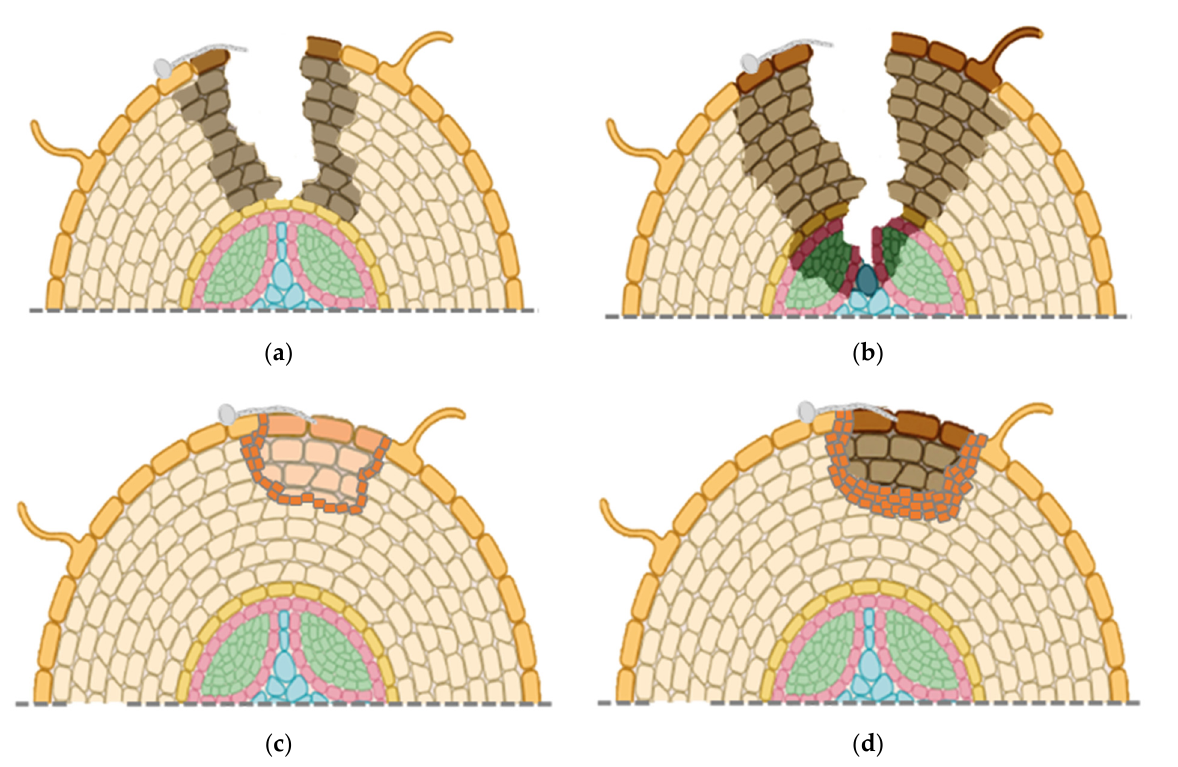
Figure 3. Ginseng root morphology with infection by the more aggressive I. mors-panacis ( a ) at the early (0.5–8 dpi); ( b ) or late stage of infection (9–30 dpi); ( c ) infection by less aggressive Ilyonectria spp. at the early (0.5–8 dpi); or ( d ) late stage of infection (9–30 dpi). The early stage of